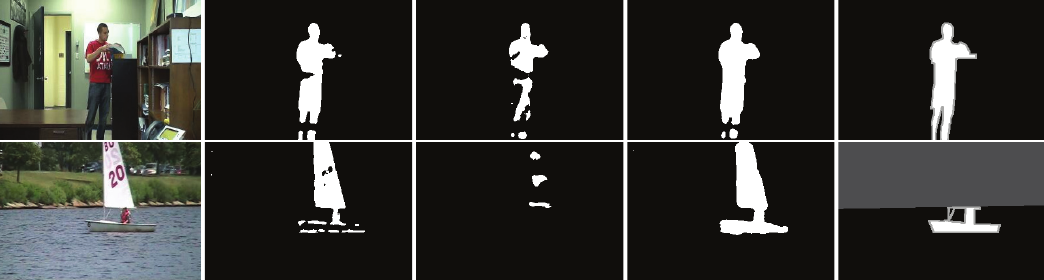
Fig. 9. Experimental results with different features on the sequences of office and boat . First column: original images. Second column: only using color features. Third column: only using LSSD features. Fourth column: combined color and LSSD features. Fifth column: the corresponding ground-truth. Gray pixels in the ground truth indicate pixels which are not of